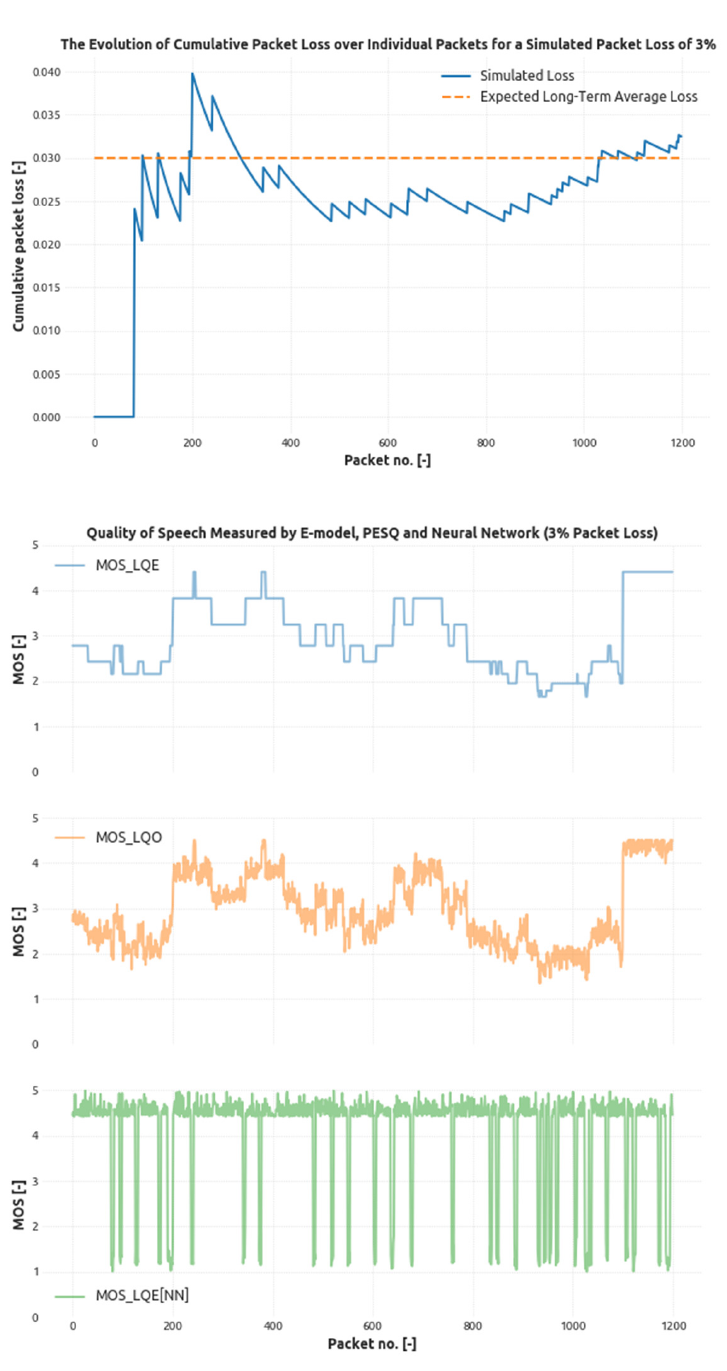
Figure 4. The evolution of the cumulative packet loss generated by the four-state loss model with given probabilities targeting the 3% loss threshold and related modeled speech quality score.